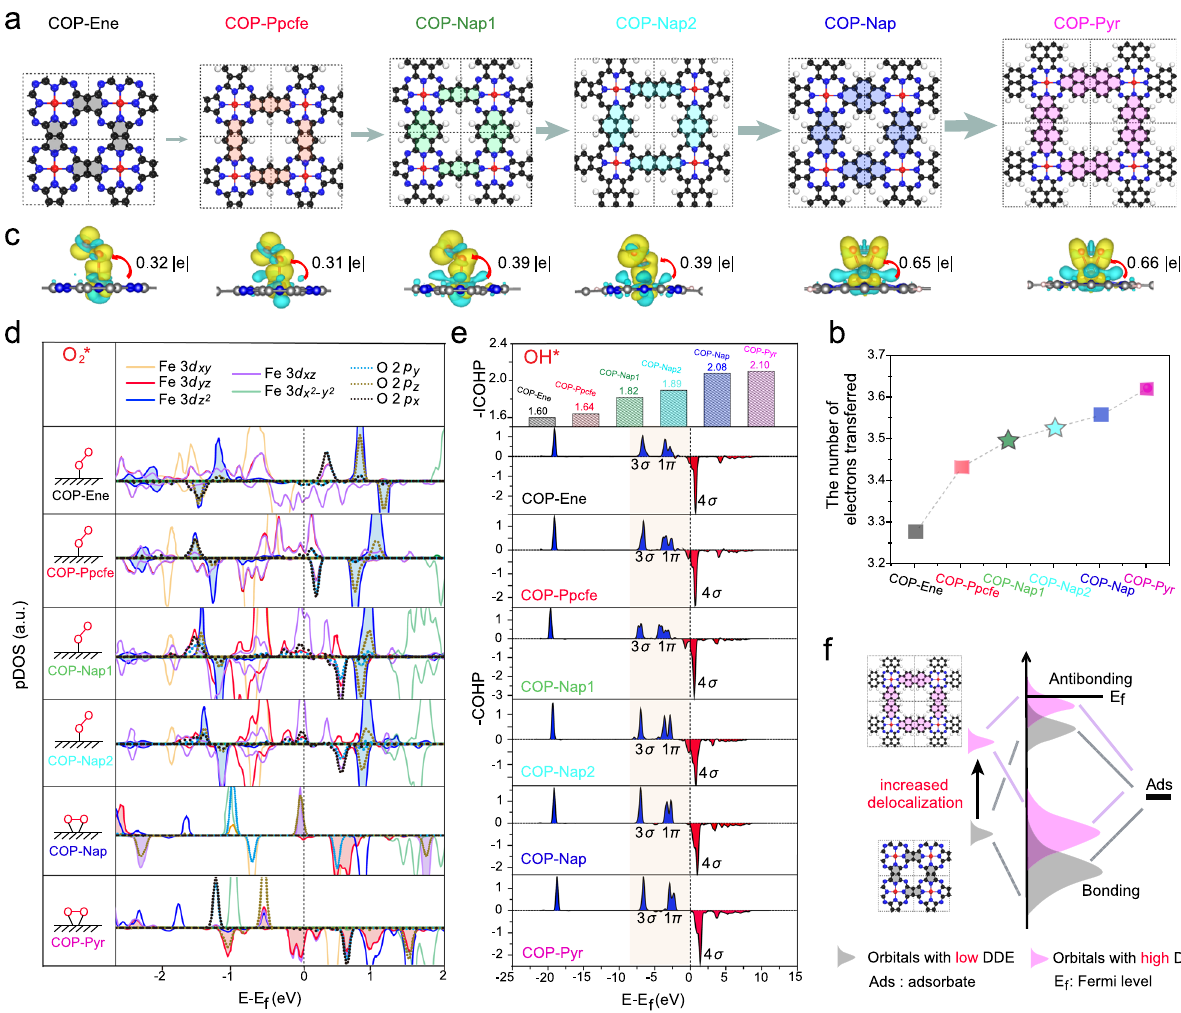
Fig. 5 The ORR mechanism revealed in depth through DFT. a Six models of COPs architectures: COP-Ene, COP-Ppcfe, COP-Nap1, COP-Nap2, COP-Nap, COP-Pyr. (In addition to the four COPs synthesized experimentally, we have also constructed Nap1 and Nap2 models to enrich the DDE in the carbon matrix. The red, dark blue, white, and black colors represent Fe, N, H, and C atoms, respectively. To distinguish their structure discrepancy, the carbon skeleton connecting the two FeN 4 sites is displayed in different colors on purpose). b Taking FeN 4 as a whole, the numbers of electrons are transferred from the surrounding C skeleton to the FeN 4 moieties (constructed COP-Nap1 and COP-Nap2 models are marked by the star symbol). c The most stable con fi gurations for oxygen adsorption and charge density differences of O 2 chemisorbed on different Fe – N – C moieties (cyan and yellow represent positive and negative charges, respectively). d Projected density of states (pDOS) plots of 2 p orbitals (2 p x , 2 p y , 2 p z ) for O 2 and 3 d orbitals (3 d xy , 3 d yz , 3 d z 2 , 3 d xz , 3 d x 2 (cid:1) y 2 ) for corresponding COPs. e Crystal orbital Hamilton population (COHP) analysis and corresponding Integrated crystal orbital Hamilton population (ICOHP) value of OH* absorbed on corresponding COP surfaces. f Schematic diagram of orbital hybridization of the adsorbates bonding orbitals and 3 d orbitals of COPs with the increment of